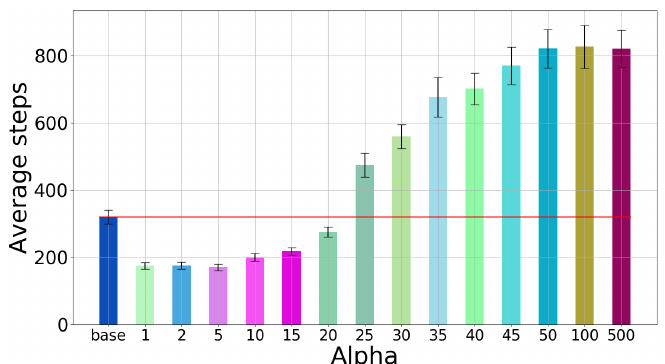
Figure 13. Single-position observations: Number of steps when varying the α